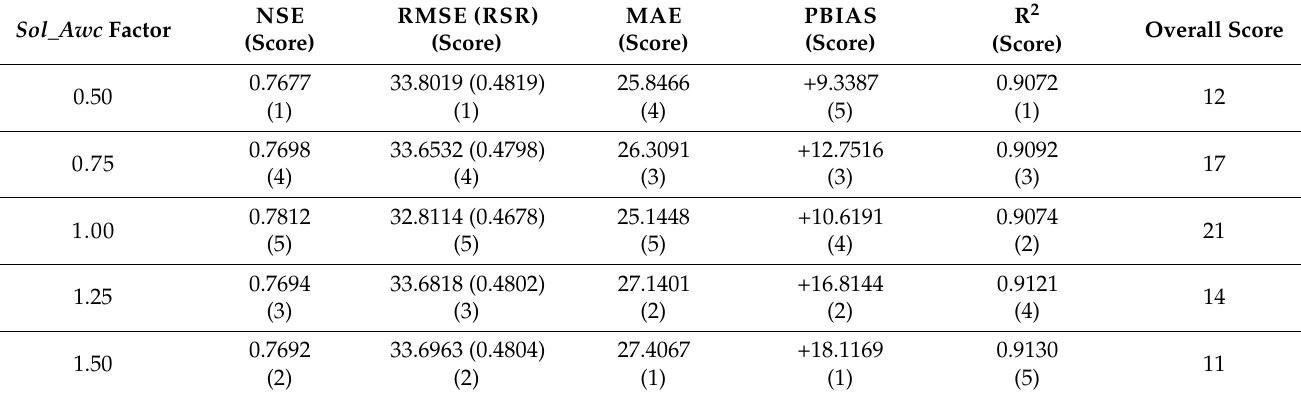
Table 3. Sample of the scoring scheme that ranks the Sol_Awc factors (case of decade